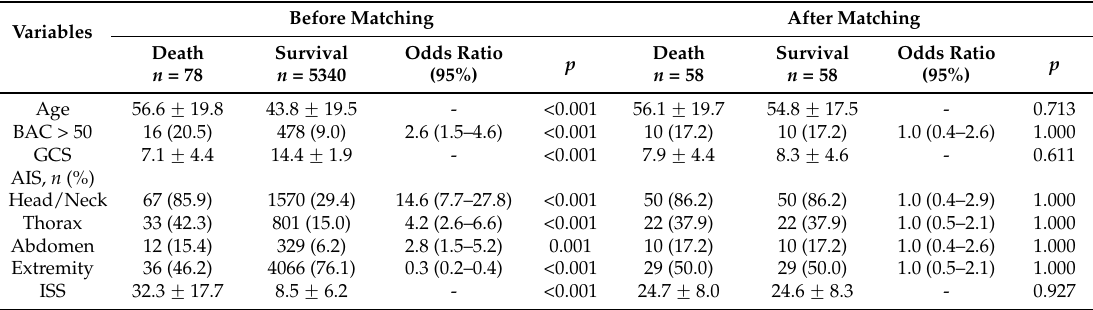
Table 4. Significant covariates of the patients transported by Emergency Medical Services (EMS) and non-EMS before and after propensity score matching (1:1 matching).